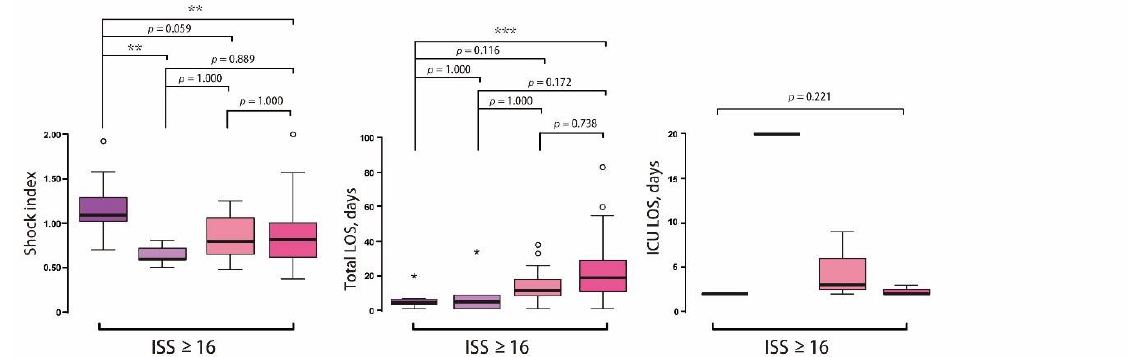
Figure 4. The distribution of shock index, total length of stay (LOS), and intensive care unit (ICU) LOS in different age in high (injury severity score, [ISS] ≥ 16) and low injury (ISS < 16).